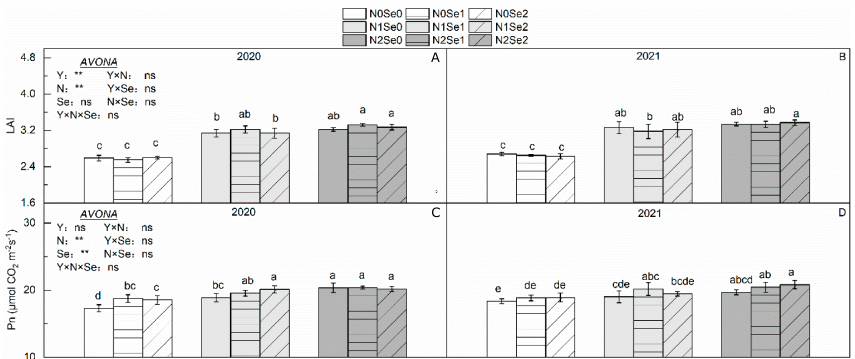
Figure 3. Effects of selenium and N fertilizers on photosynthetic capacity in wheat. Y = Years, N = Nitrogen, Se = Selenium. ( A , C ) represent LAI and Pn in 2020, respectively. ( B , D ) represent LAI and Pn in 2021, respectively. N0, N1 and N2 indicate 0 kg N ha − 1 , 180 kg N ha − 1 and 270 kg N ha − 1 , Se0, Se1 and Se2 indicate 0 g Se ha − 1 , 450 g Se ha − 1 and 900 g Se ha − 1 . Different lowercase letters indicate statistical differences among treatments at p < 0.05. “ns” means no significant difference ( p > 0.05). ** represent the significance levels of p < 0.01,